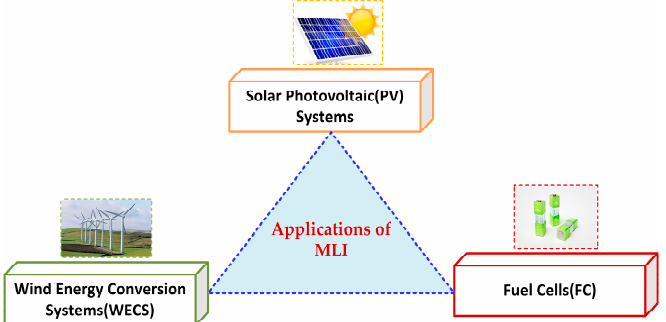
Figure 11. Various applications of Multilevel Inverters.